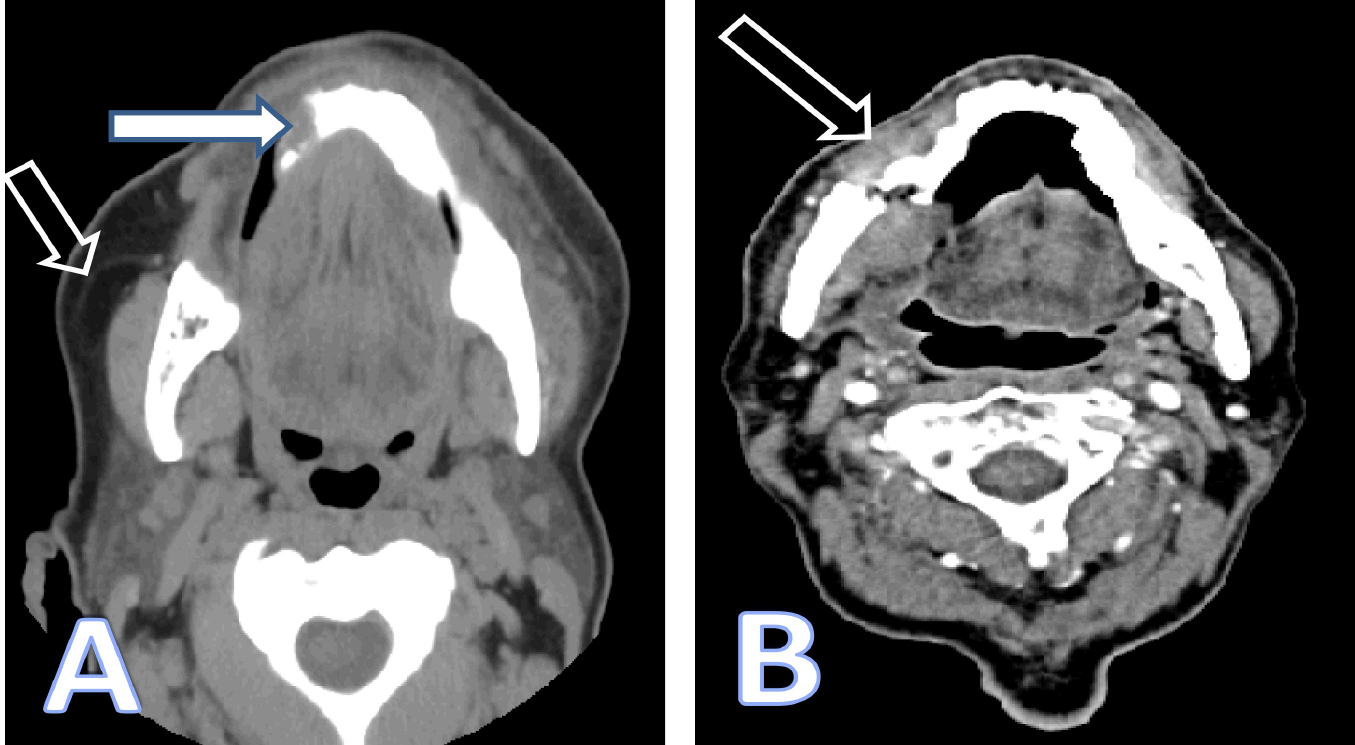
Figure. Computed tomography of the face without (A) and with (B) intravenous contrast. (A) Mandibular sclerosis with periosteal reaction of the mandibular body extending to the parasymphyseal region; given history of bisphosphonates therapy most likely osteonecrosis (full arrow). Diffuse subcutaneous edema and submental soft tissue swelling reflecting focal inflammatory changes (hollow arrow). (B) Osteoradionecrosis of the mandible with pathologic fracture of the right horizontal mandibular ramus